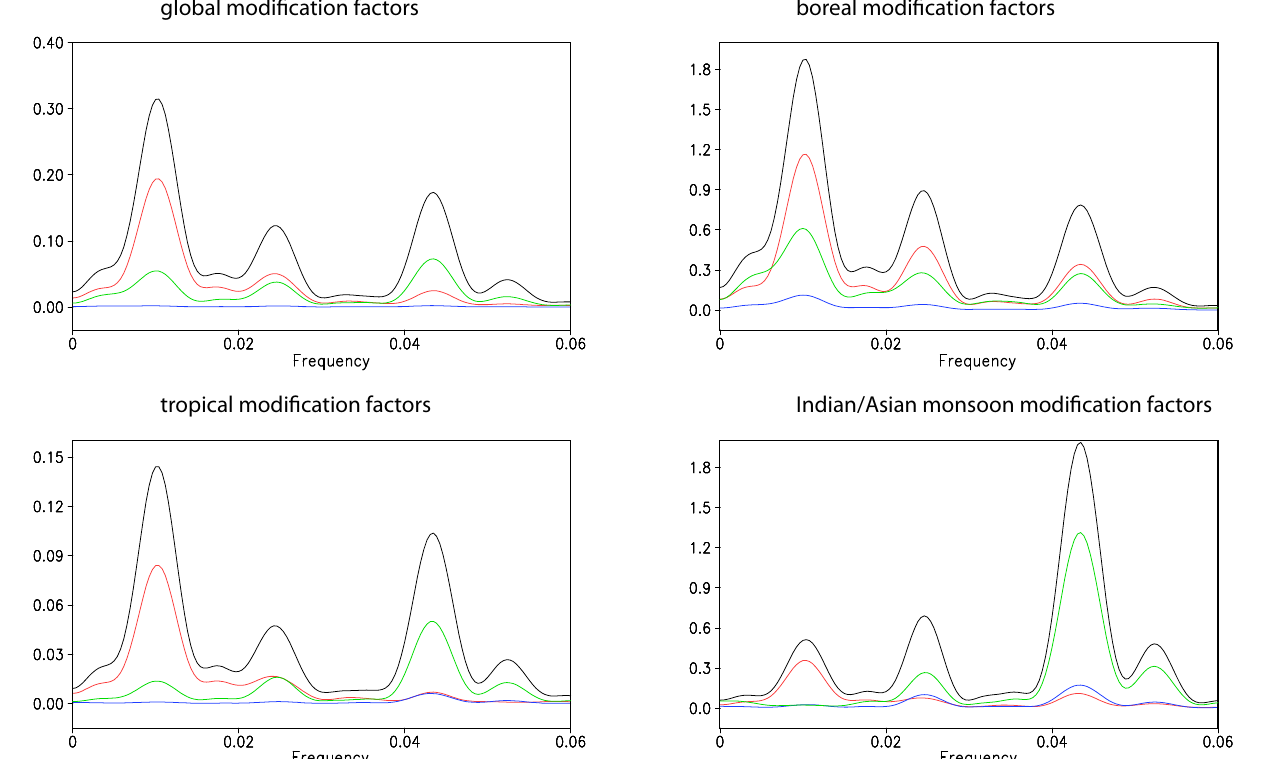
Fig. 10. Spectra of the modification factors (see Sect. 3.2) for the entire globe, and for the tropical, boreal and Indian/Asian monsoon areas